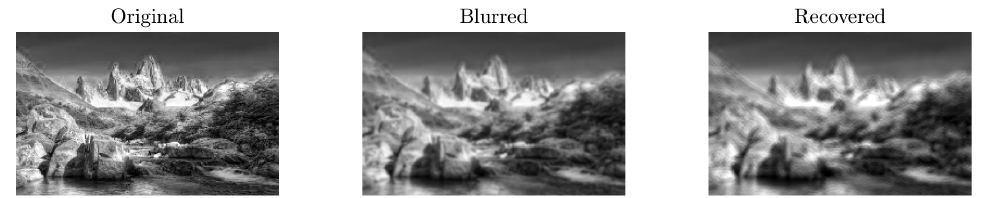
Figure 9. Low-resolution natural images could not be deblurred by the first independent component analysis method.